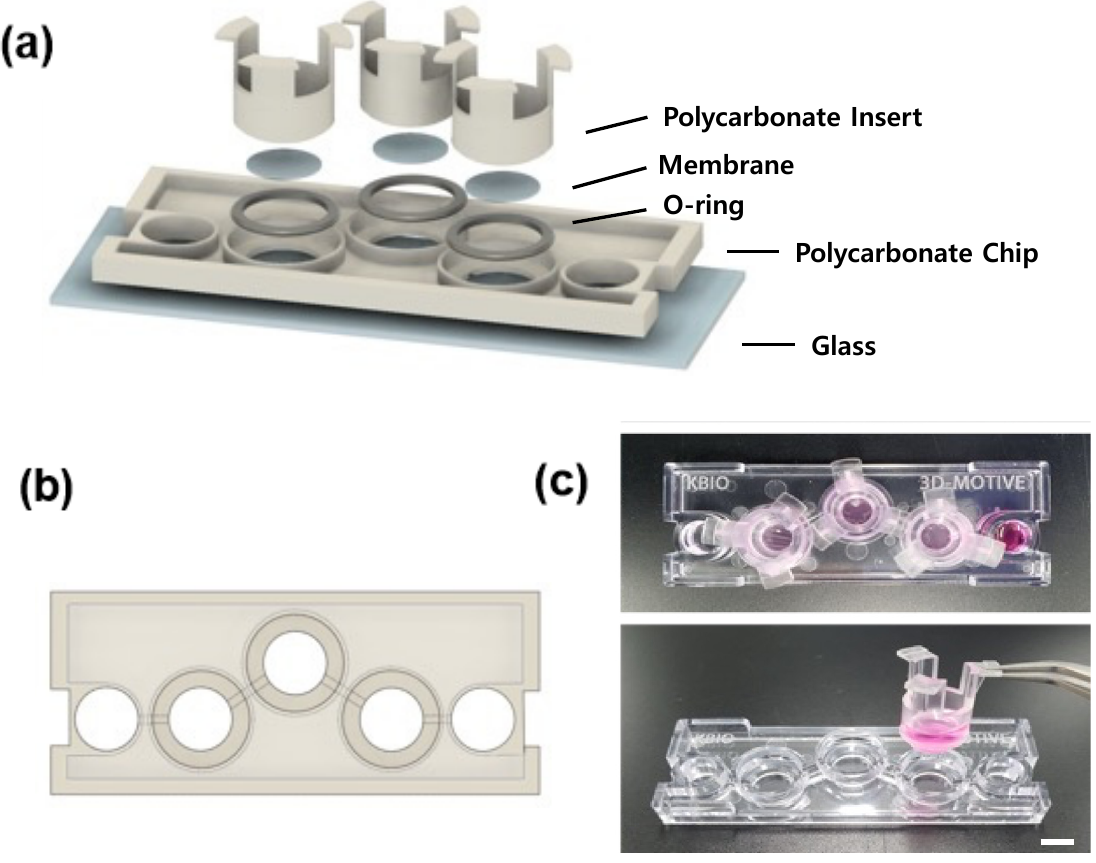
Figure 1. Injection-molded chip schematic and actual photograph. ( a ) Injection-molded chip with insert module installed. ( b ) Polycarbonate. ( c ) Actual photographs of injection-molded chip and insert.